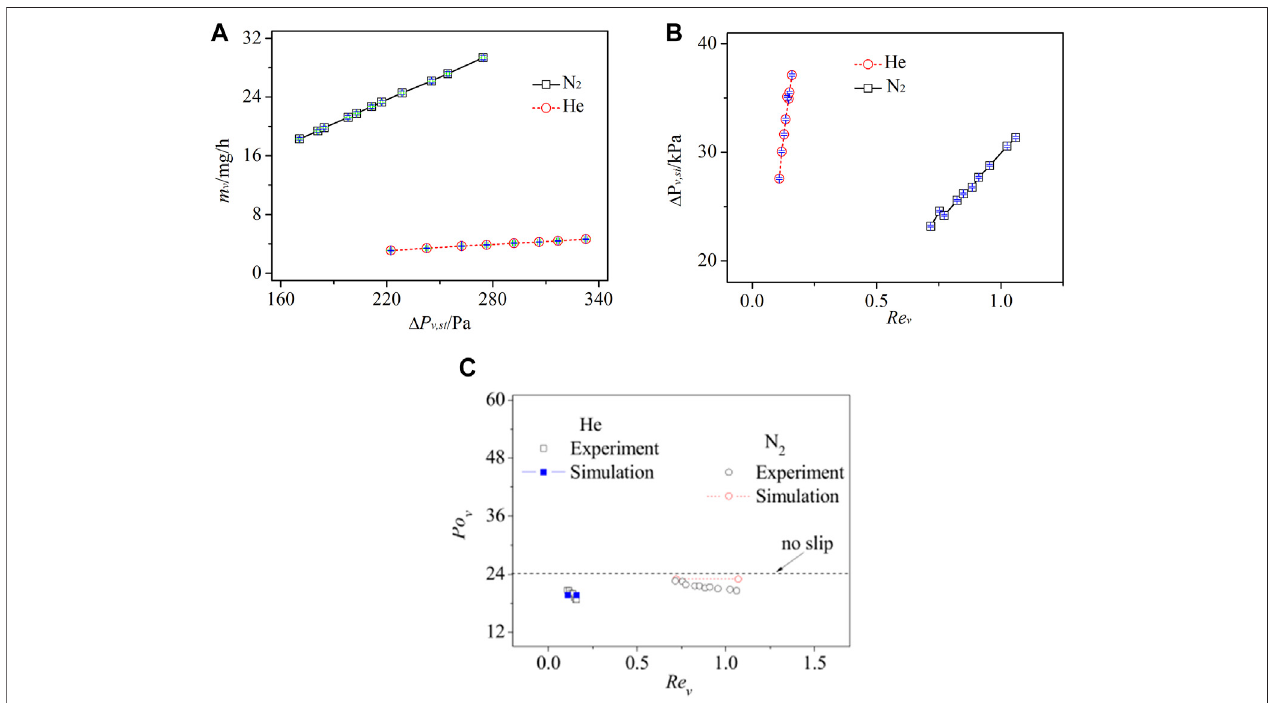
FIGURE 3 | Experimental results. (A) Gas mass fl ow rate measured experimentally. (B) Pressure drop of gas fl ow in silicon microchannel. (C) Comparison of theoretically predicted value and experimental data of the Poiseuille number of gas fl ow in silicon